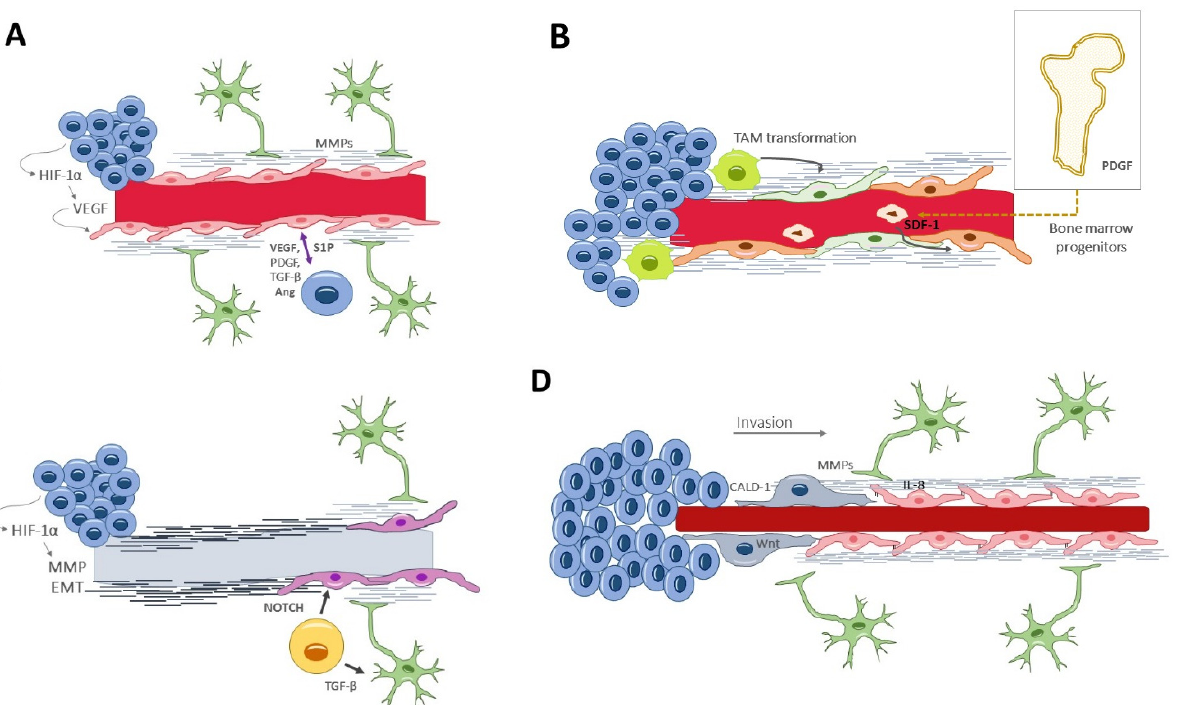
Figure 2. Vascular generation and related processes: ( A ) angiogenesis, the formation of new vessels from pre-existing ones. In glioblastoma, it appears in a late stage of tumor development and within the necrotic niche. ( B ) Vasculogenesis, recruiting circulating cells into neoformed vessels, relies on bone marrow-derived progenitors or tumor-associated macrophages that differentiate into endothelial cells. It happens in late stages of tumor evolution. ( C ) Vascular mimicry consists of neoformation of vessel-resembling structures that lack endothelial cells. Glioblastoma-endothelial-cell transdifferentiation is complementary to vascular mimicry and may provide a pseudoendothelial coverage to the otherwise acellular tubular structures. ( D ) Vascular co-option is a process of tumor invasion along the basolateral surface of healthy vessels. Thus, this process happens in the invasive front, in the early oncologic phase. Ang, angiopoietin; CALD1, caldesmon; EMT, epithelial–mesenchymal transition factor; HIF-1 α , hypoxia-inducible factor; Il-8, interleukin-8; MMPs, matrix metalloproteinases; PDGF, platelet-derived growth factor; TGF- β , S1P, Sphingosine-1-phosphate; Transforming growth factor β ; VEGF, vascular endothelial growth factor.